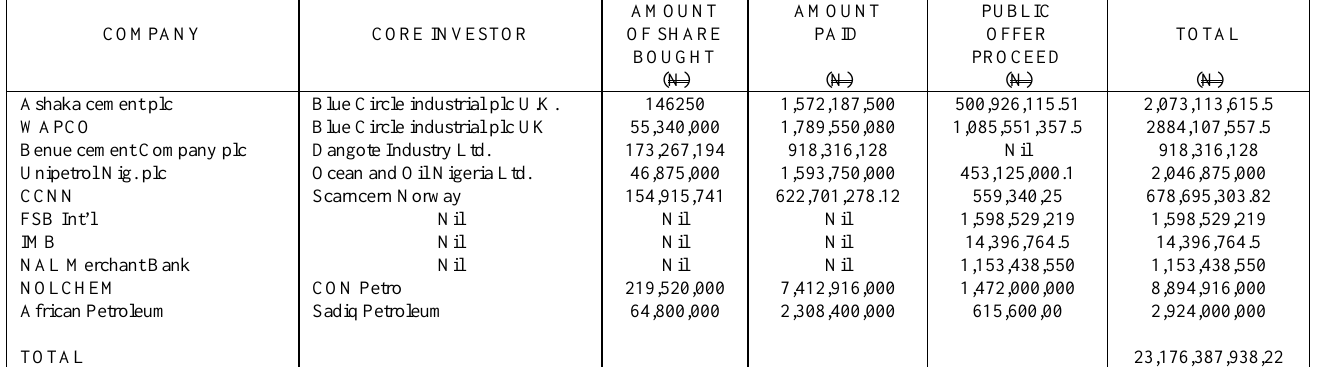
TABLE 2: PROCEEDS OF PRIVATISATION (Second Phase) COMPANY